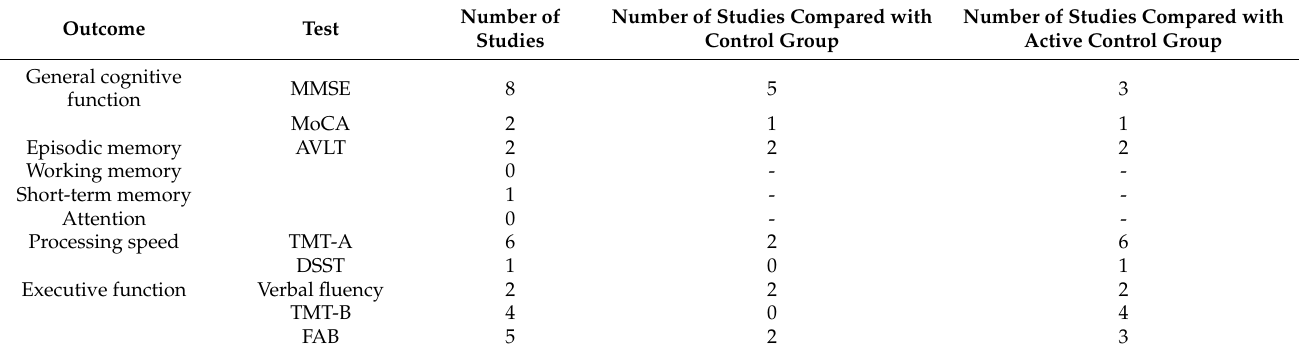
Table 2. Description of clinical assessment scale in different domains.